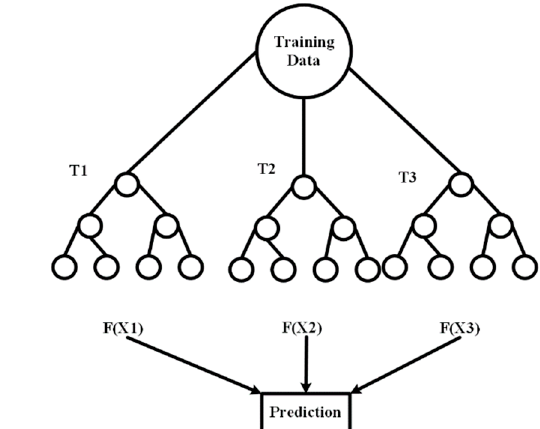
Figure 2. Sigmoidal Curve. Description: Here, ‘x’ can be any dependent attribute.